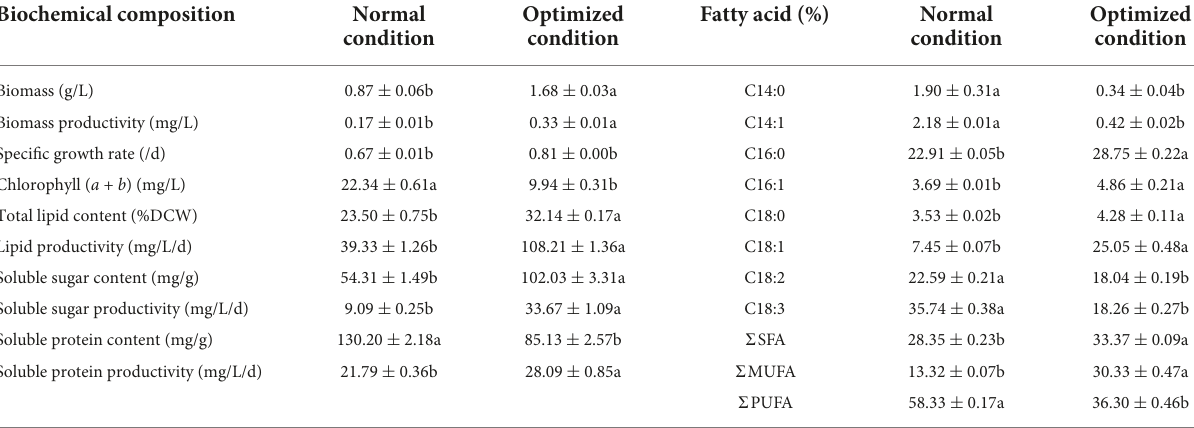
TABLE 4 The biochemical compositions and fatty acid profiles of C. reinhardtii under normal and optimized conditions. Biochemical composition Normal